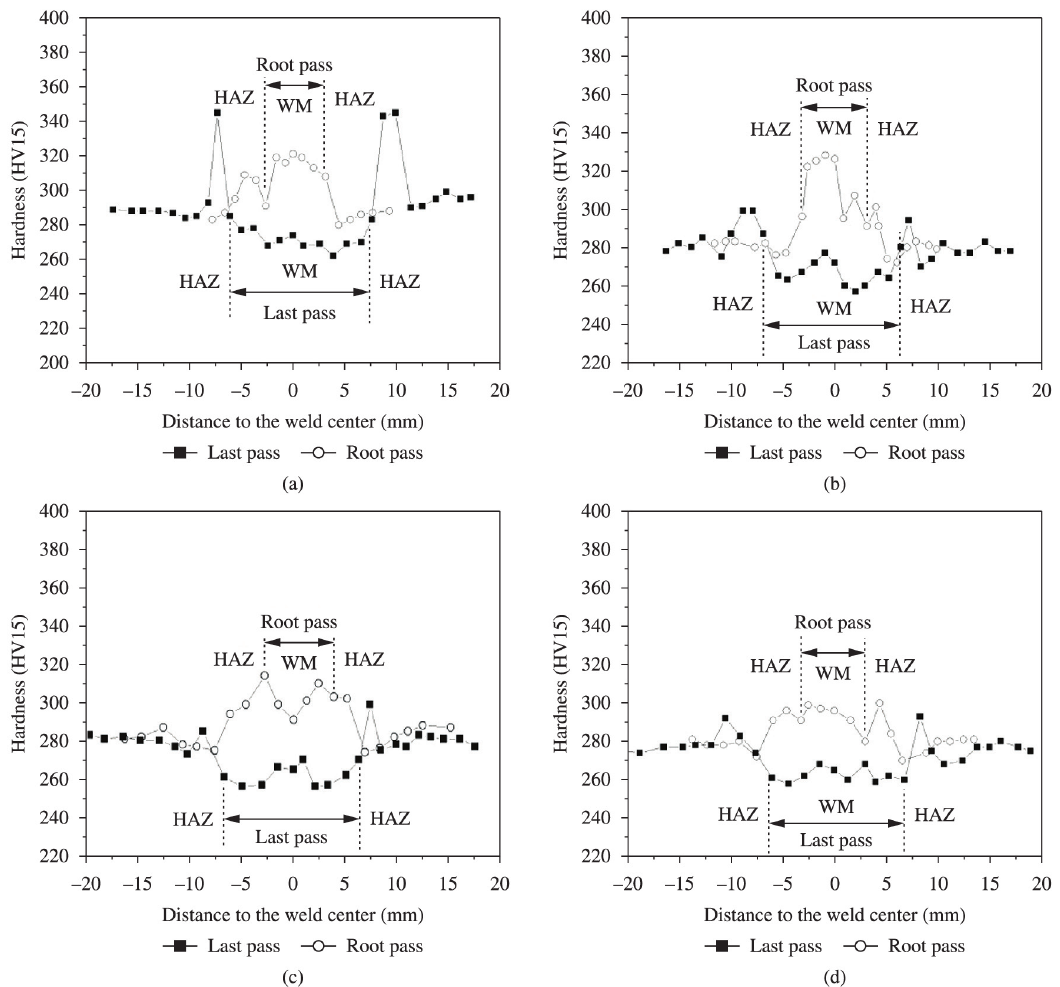
Figure 4. Hardness profiles of specimens heat treated at 650ºC for: (a) 15 min.; (b) 30 min.; (c) 45 min.; and (d) 60 Table 2. Estimated chemical compositions of regions of the weld metal (see Figure 1 ). Cr Region